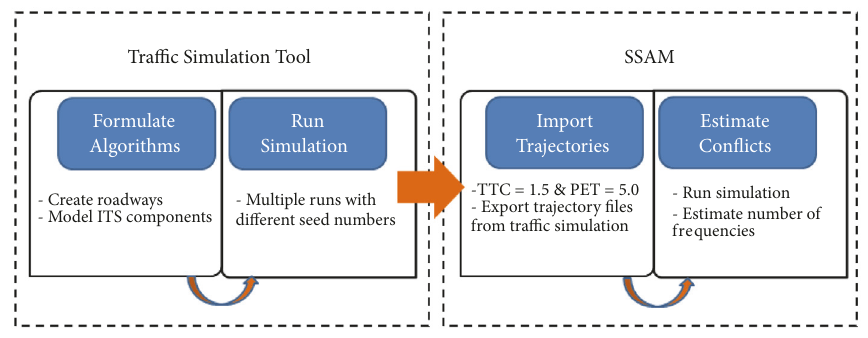
Figure 2: Integration platform of traffic simulation tool and